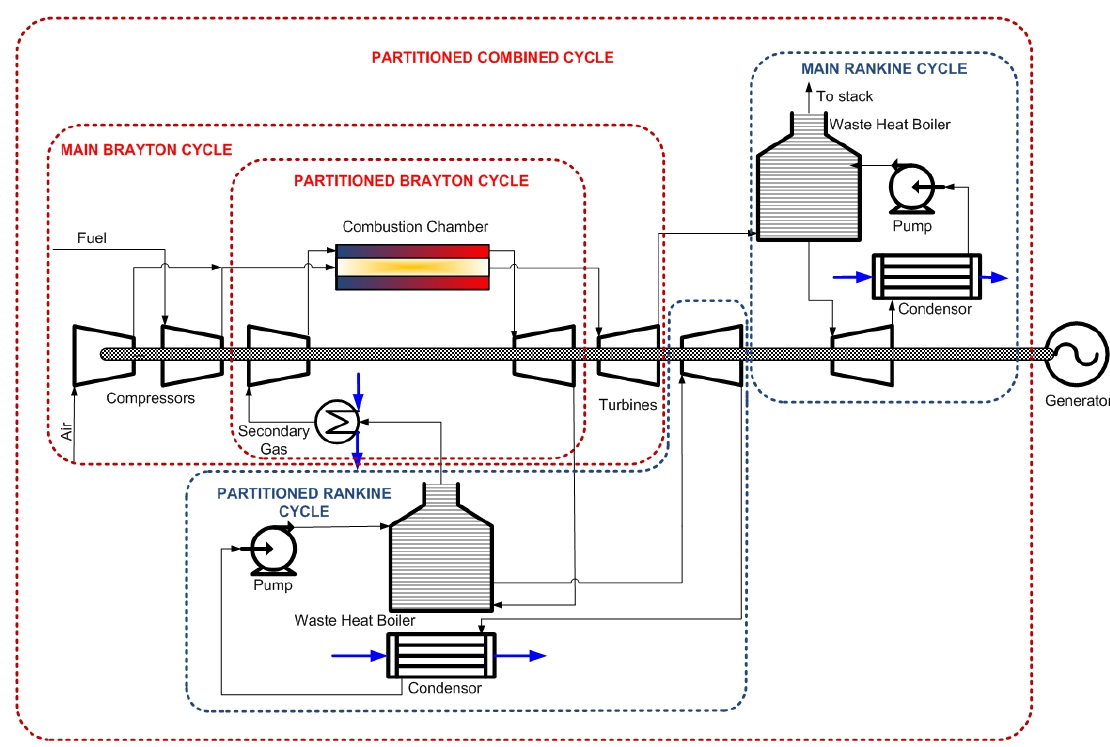
Figure 2. Novel proposed partitioned Brayton and Rankine cycles (PCGT) to efficiently recover cycle exhaust energy. Contrary to the main cycle, the partitioned Brayton cycle is a closed one.